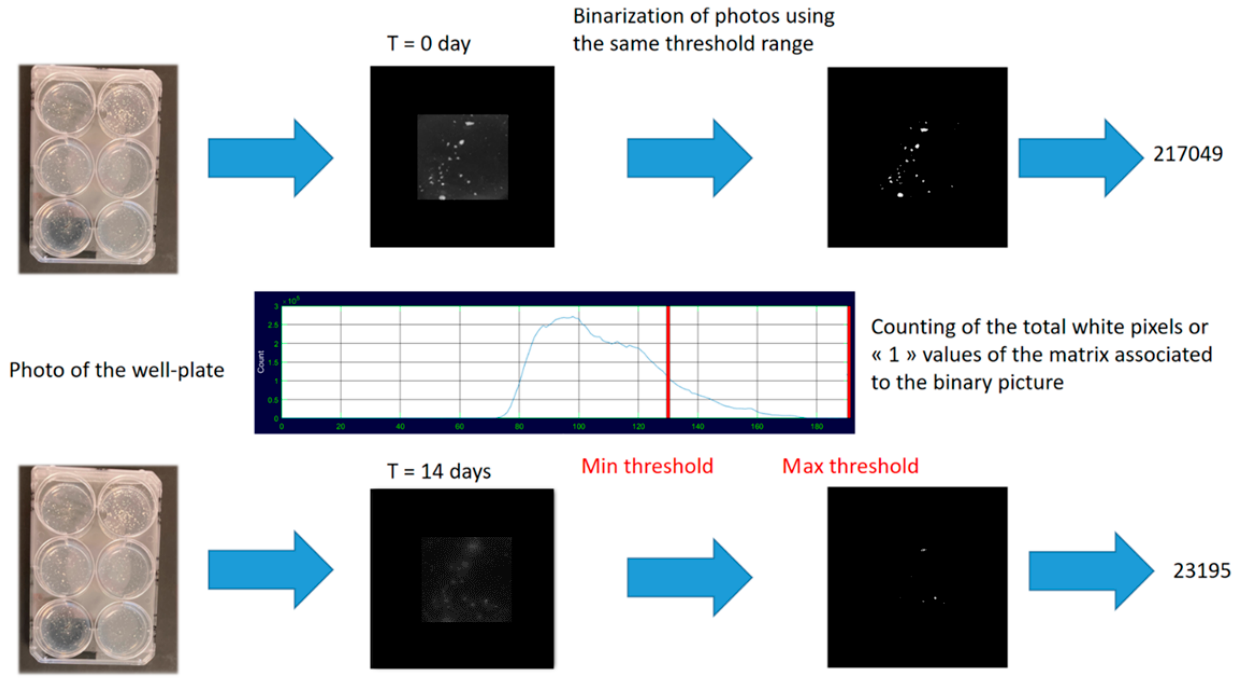
Figure 7. Image treatment and analysis process.